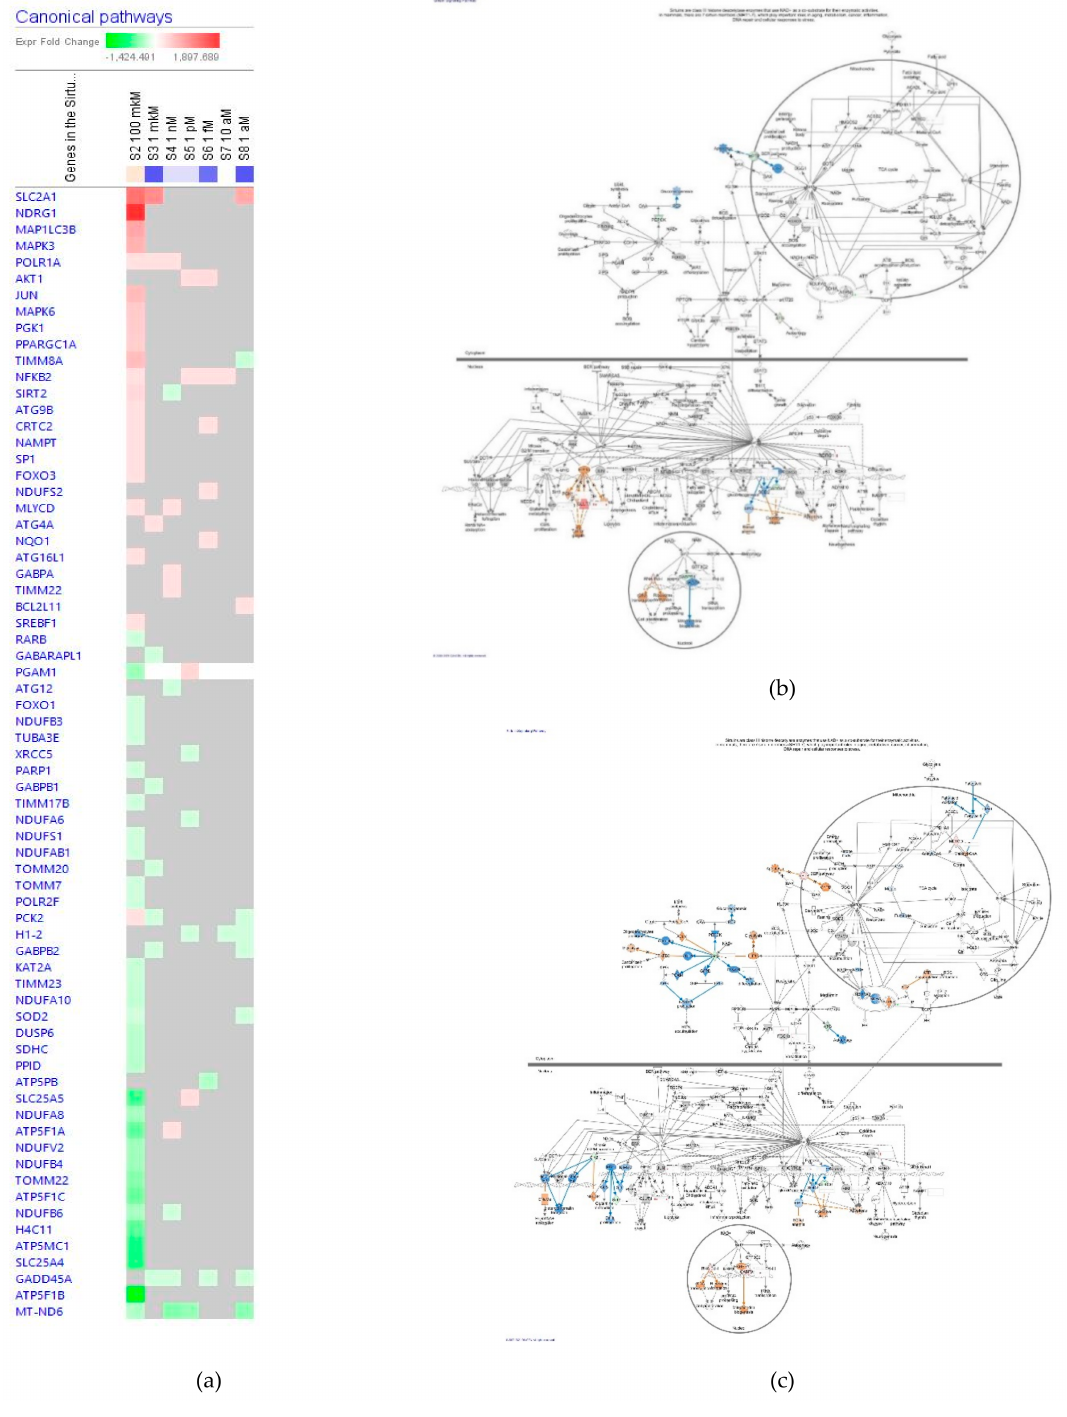
Figure 11. Effect of Rg5 on SIRT signaling pathway in neurons: ( a )—Heatmap of gene expressions (in fold changes compared to control, red, upregulation and green—downregulation), after exposure of neurons with ginsenoside Rg5 in different concentrations; the 100 µ M signature is shown in the leftmost column as solid red or green squares indi- cating genes that are upregulated or down-regulated, respectively; color intensity indicates the actual log-fold changes; ( b ) Rg5 in the concentration of 100 µ M—predicted inhibition (blue) and activation (brown); ( c ) Rg5 in the concentration of 1 nM—predicted inhibition (blue) and activation